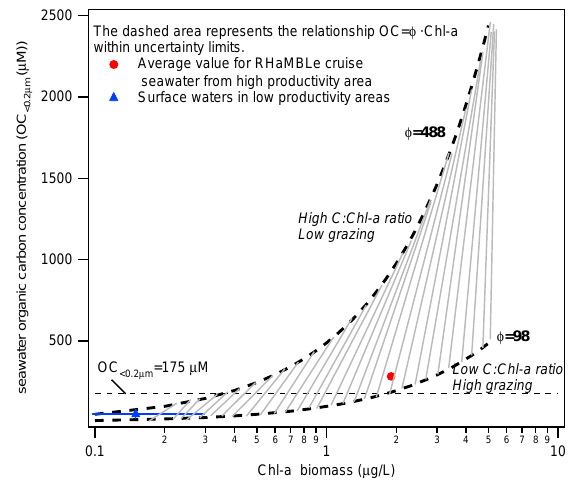
Fig. 16. The dashed area represents the relationship between Chl- a and seawater OC < 0 . 2 µ m concentration, as obtained from the vari- ation of the parameters defined in Eq. (7). The magnitude of the region indicates that the relationship is highly dependent on the specific conditions of the algal bloom, i.e., C:Chla ratio, grazing rate and lifespan of phytoplankton cells. The data provided for low biological activity areas is defined considering SeaWiFFs Chl- a data and seawater organic carbon concentrations from Owaga and Tanque (2003). The horizontal dashed line at OC < 0 . 2 µ m =175µM indicates that an impact of the biological activity on primary par- ticle fluxes is likely to occur for diatom Chl- a biomass concentra- tions > 0.35–2µg/L, depending on the specific conditions in the al- gal